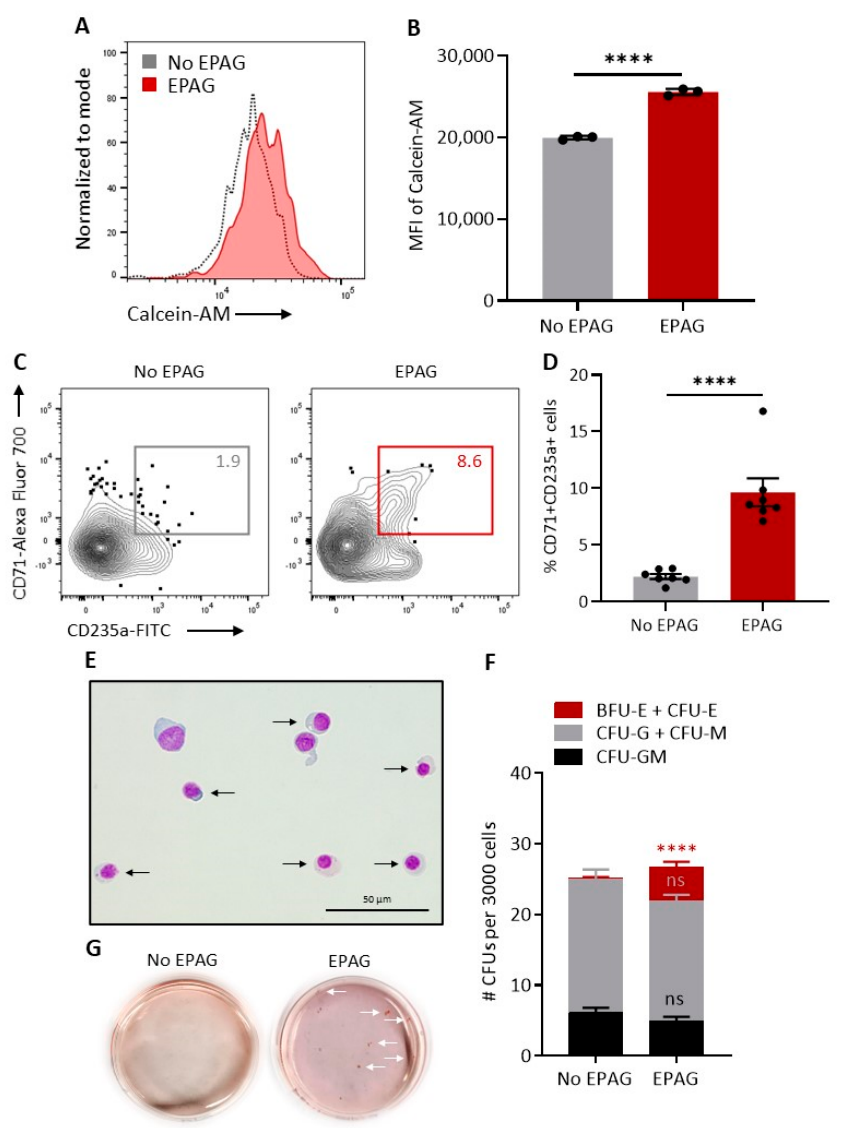
Figure 3. Defective erythropoiesis in DBA iPSCs is partially rescued by eltrombopag (EPAG). ( A , B ) Quantification of intracellular iron chelating properties of EPAG in erythroid cells differentiated from isogenic iPSCs. Representative flow cytometry histograms of intracellular calcein-AM fluorescence (A) and summary of the mean fluorescence intensity of calcein-AM (B) in isogenic iPSC-derived erythroid cells loaded with calcein-AM and then treated or not with EPAG. Peak height of histogram was normalized to mode ( C ) Representative flow cytometry contour plots depicting percentages of late-stage CD45 − erythroblasts co-expressing CD71 and CD235a at culture day 21 of isogenic iPSC differentiation in the presence or absence of EPAG. ( D ) Percentages of CD71 + CD235a + late-stage CD45 − erythroblasts at culture day 19 or 21 of isogenic iPSC differentiation in the presence or absence of EPAG ( n = 7). ( E ) Representative Giemsa stains of hematopoietic cells at culture day 21 of isogenic iPSC differentiation in the presence of EPAG. ( F ) Number of colony forming units (CFUs) per 3000 hematopoietic cells harvested at culture day 19 or 21 of DBA iPSC differentiation in the absence or presence of EPAG ( n = 8). ( G ) Representative CFU plates for hematopoietic cells harvested at culture day 21 of DBA iPSC differentiation in the presence or absence of EPAG. White arrows point to erythroid colonies. In panels B, D and F, data are presented as mean ± SEM. In panel F, statistical analysis is presented for each colony type relative to the “No EPAG” group. Unpaired t -test, **** p ≤ 0.0001, ns: not